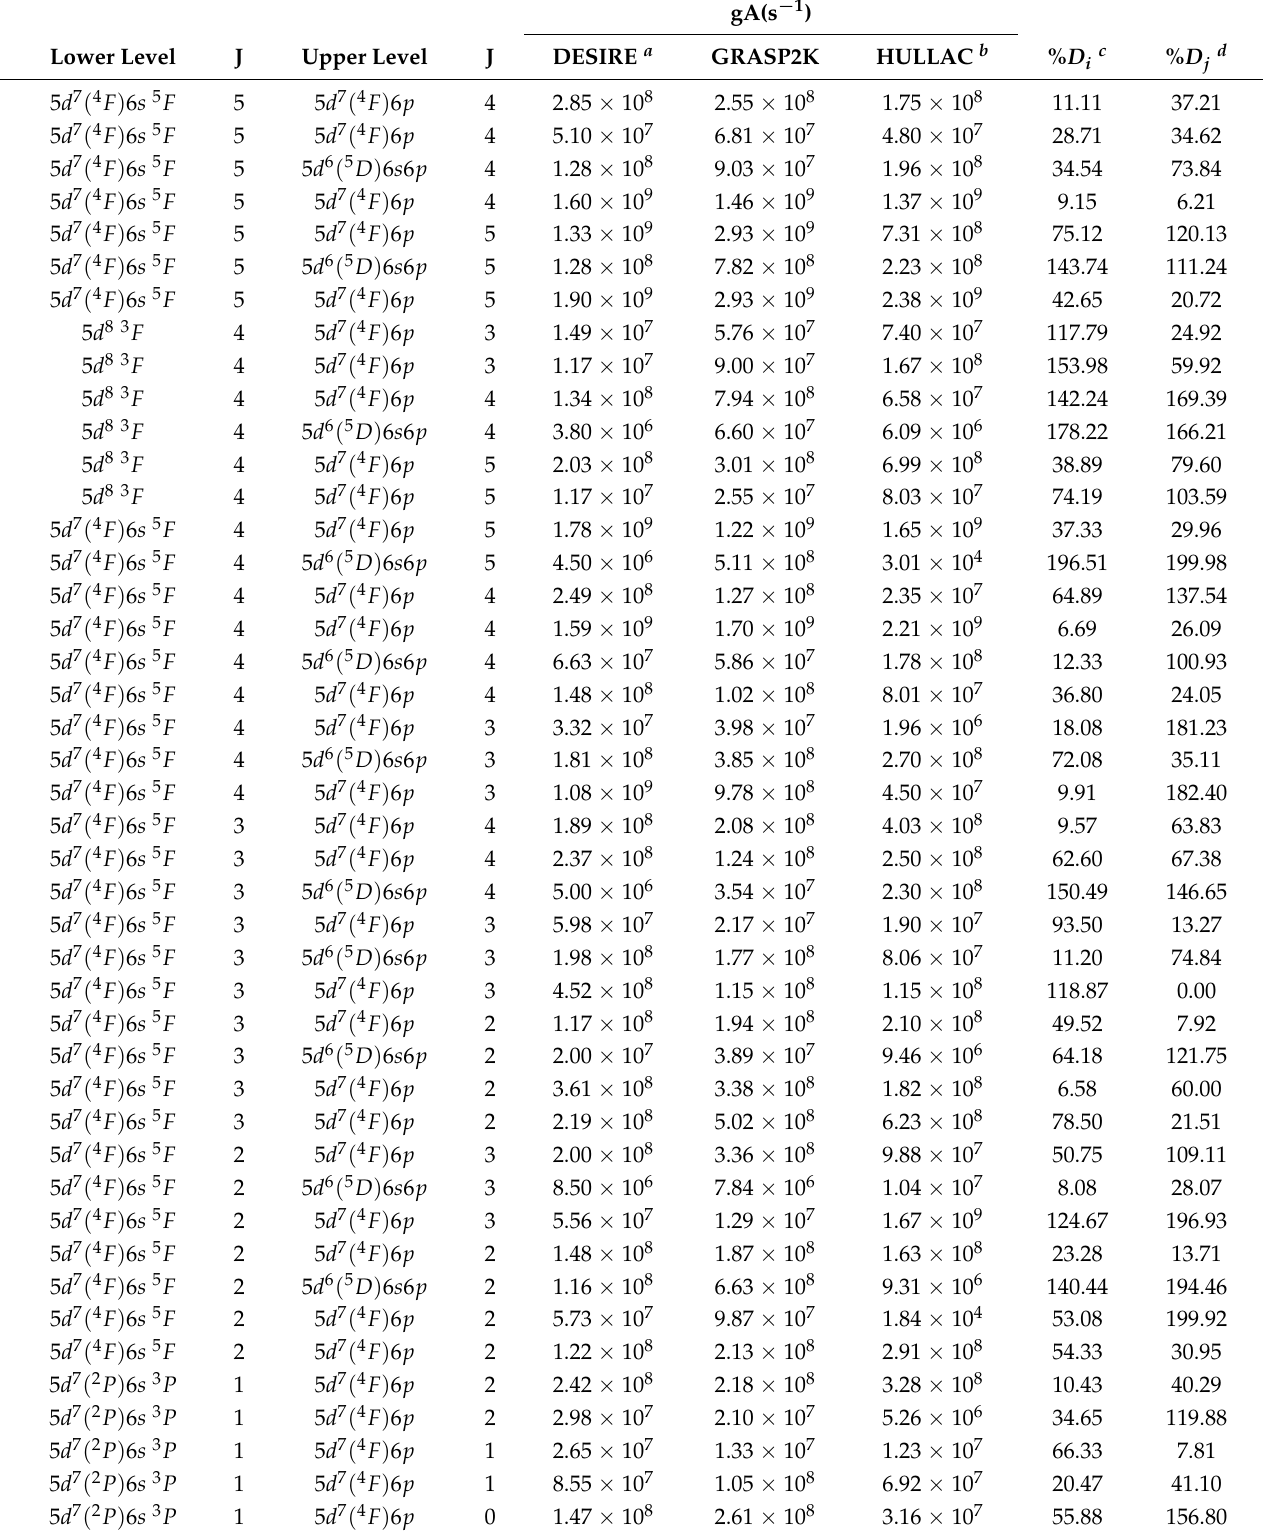
Table 7. Weighed transition probabilities (gA-values) for Ir